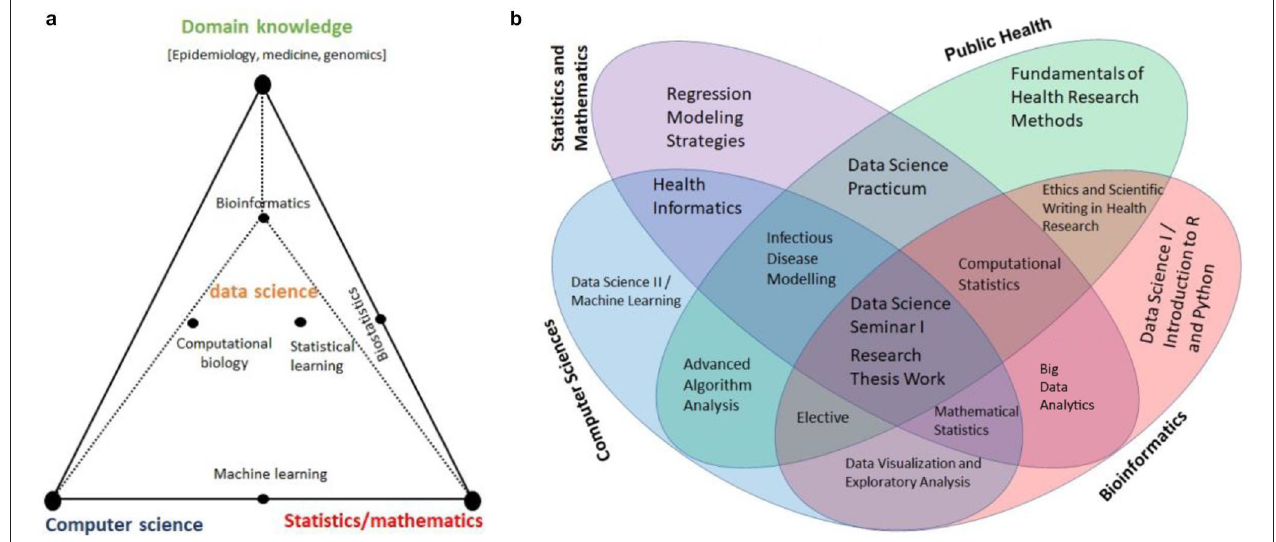
FIGURE 1 | (a) Schematic Visualization of the three Pillars: Computer Science/Informatics, Statistics/Mathematics, and domain knowledge expertise [Adapted from (21)], and (b) Multidisciplinary Expertise, Skills and Relevant Courses for Health Data Science